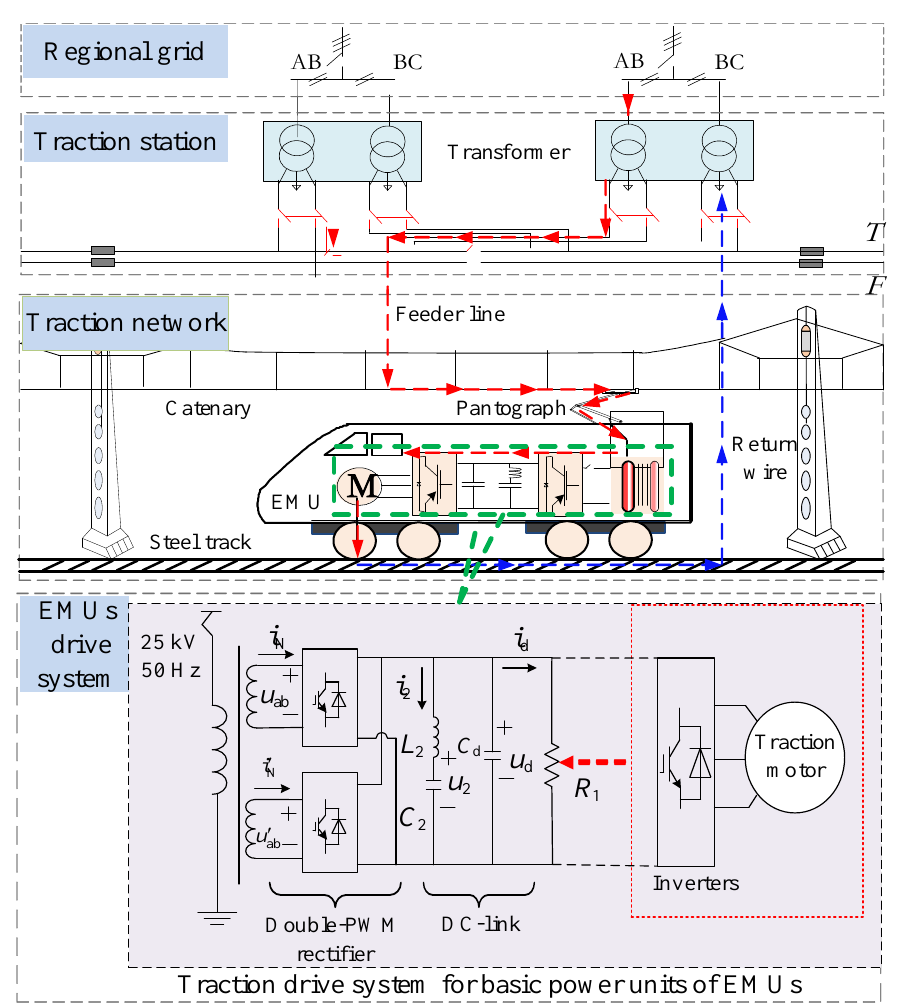
Figure 1. Schematic of traction network and electric multiple units (EMUs). PWM: pulse-width modulation; DC: direct current.